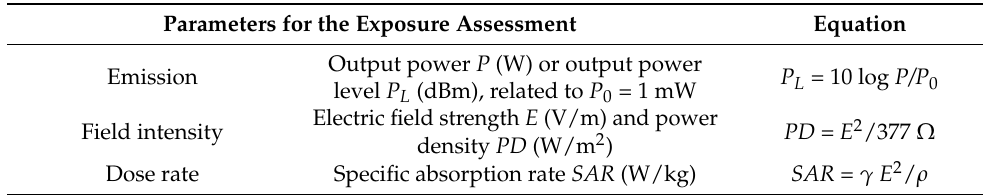
Table 2. Parameters to characterise the exposure to RF-EMFs: output power of the EMF-emitting sources, the field intensity, and the dose rate [14].